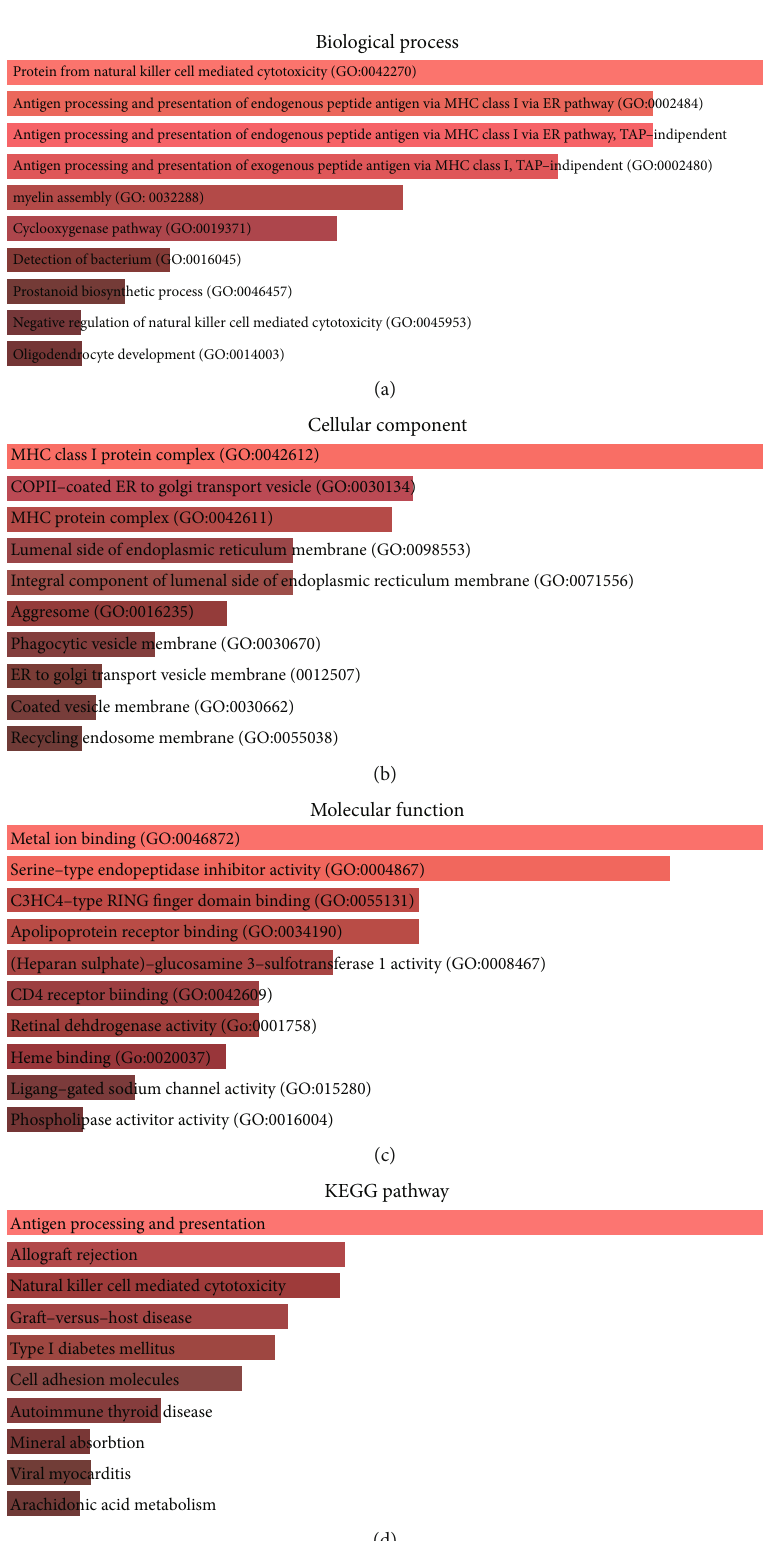
Figure 3: Functional analysis of common DEGs in GSE140202 and GSE143233. (a) The GO_biological process enrichment analysis of common DEGs in GSE140202 and GSE143233. (b) The GO_cellular component enrichment analysis of common DEGs in GSE140202 and GSE143233. (c) The GO_molecular function enrichment analysis of common DEGs in GSE140202 and GSE143233. (d) The KEGG pathway enrichment analysis of common DEGs in GSE140202 and